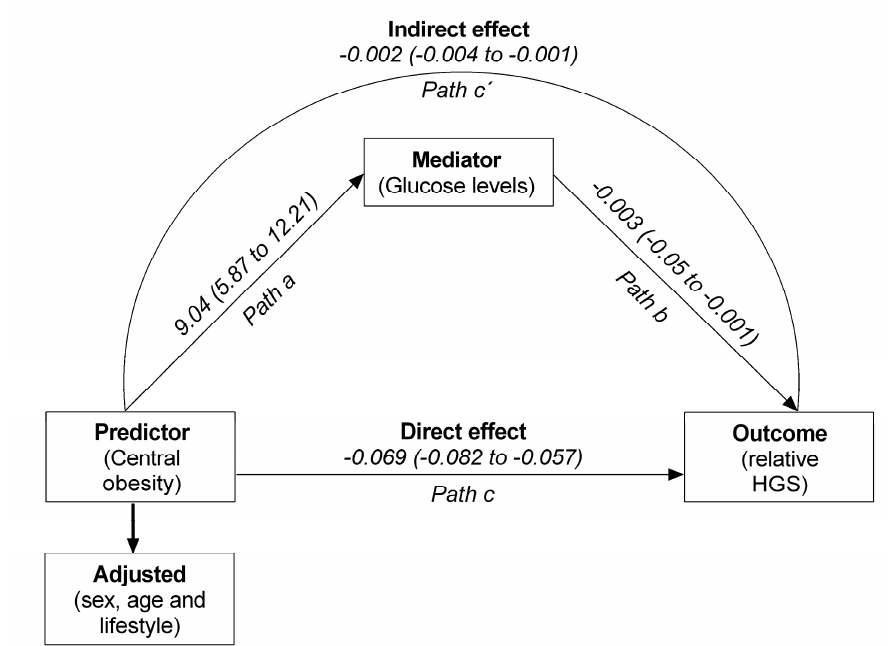
Figure 3. The direct effect of abdominal obesity status (healthy versus unhealthy) on relative HGS gives through fasting glucose level. In the model, abdominal obesity has an inverse relationship with relative HGS. This relationship is mediated by fasting glucose level as the active ingredient (in this case, harmful ingredient). The indirect effect is statistically significant at the 95% confidence interval (CI) when the CI does not include zero.